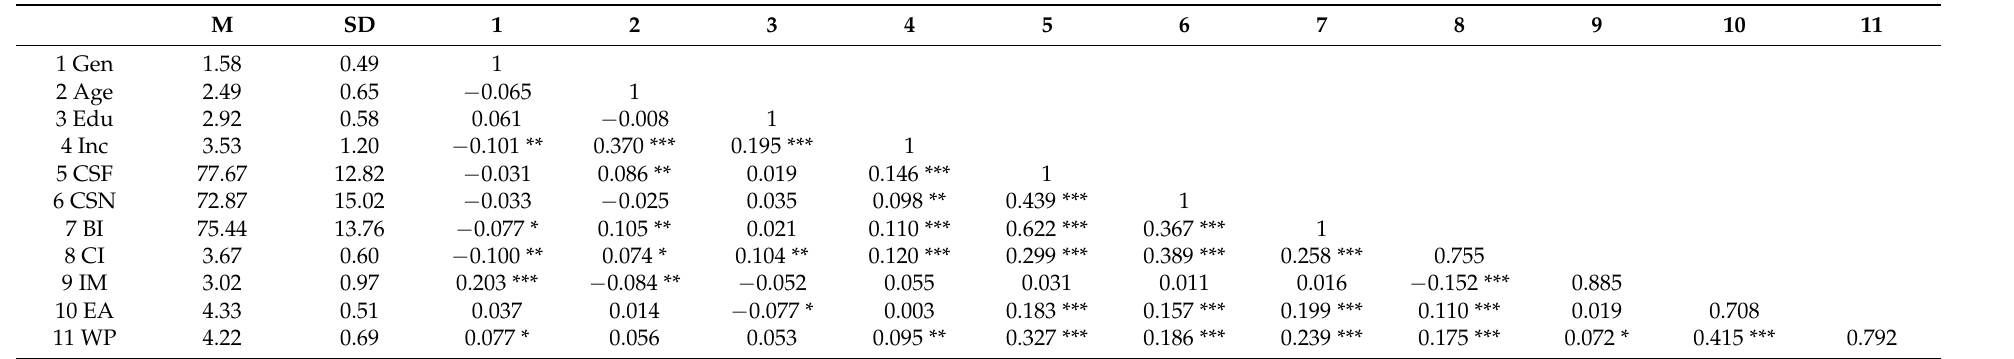
Table 4. Means, Standard Deviations, and Correlation